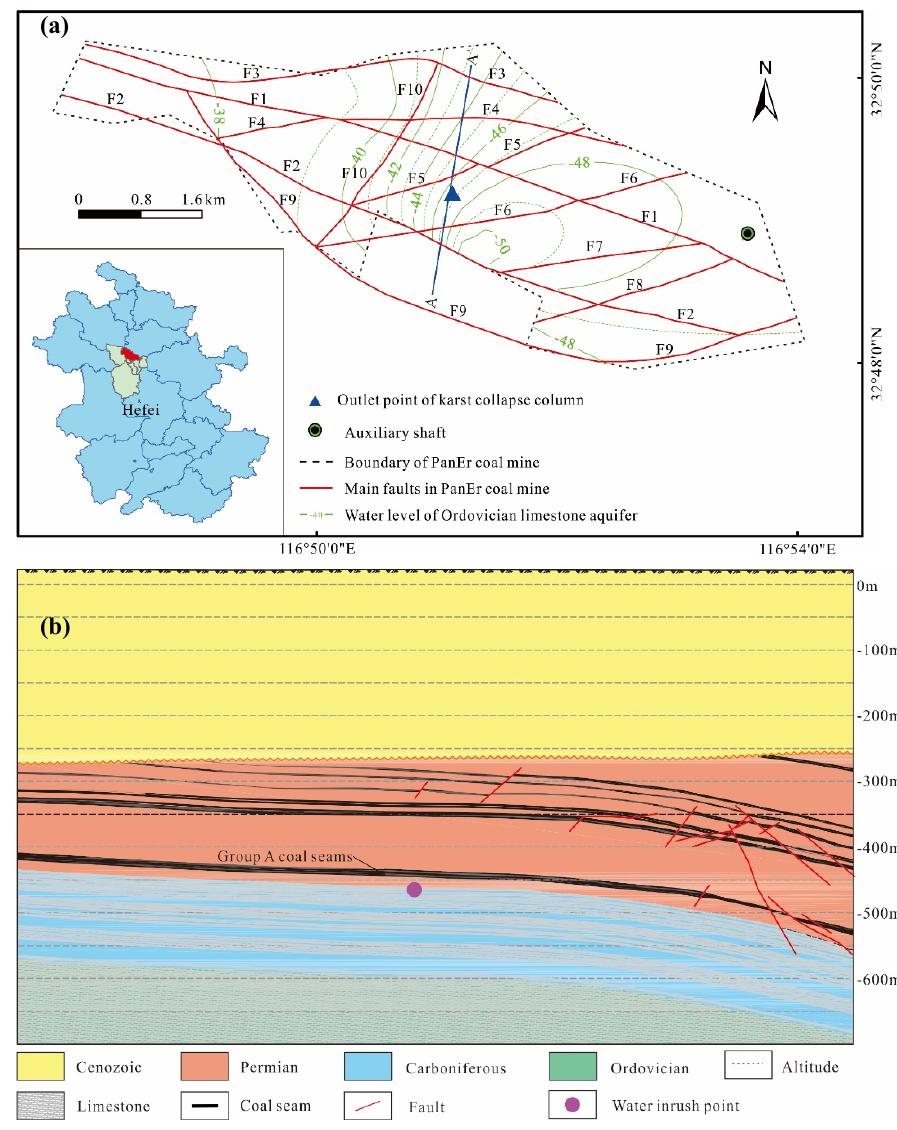
Figure 1. Location, geological plan, and profile of the study area. ( a ) location and geological plan; ( b ) geological profile.